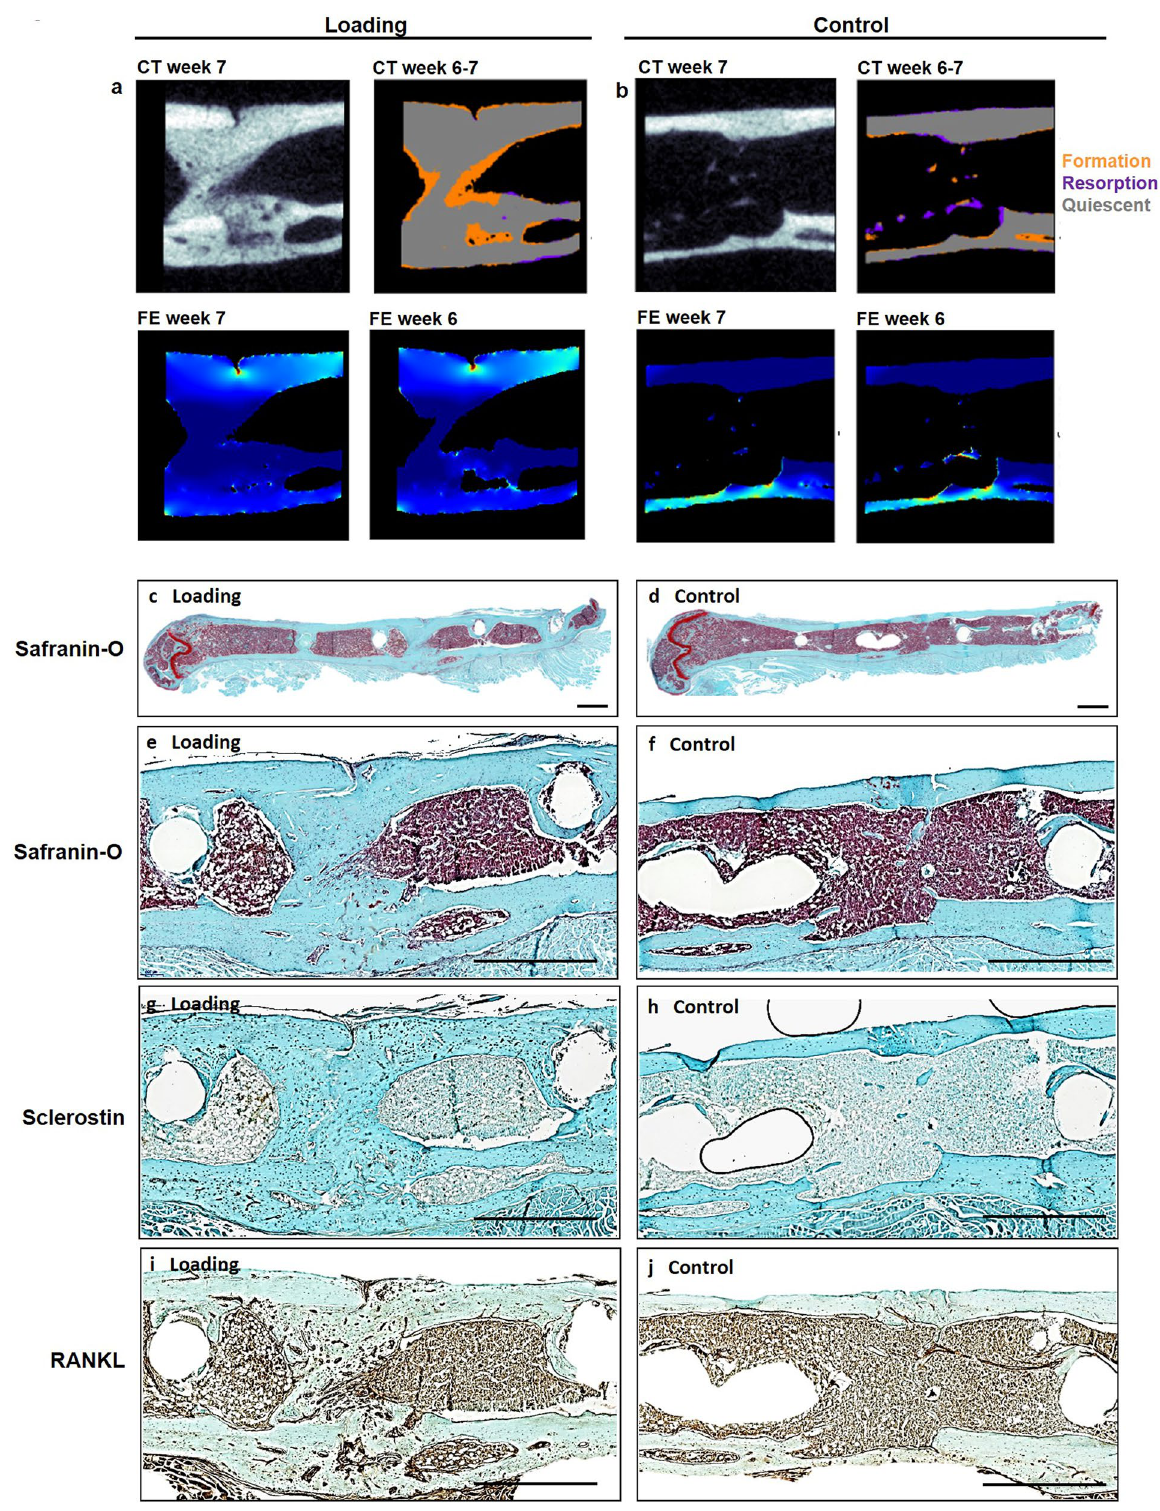
Figure 4. Micro-CT and histological analyses of consecutive callus sections. ( a , b ): Micro-CT images of fracture callus sections corresponding to sections stained with Safranin-O for one animal from the loading ( a ) and the control group ( b ): CT image (threshold: 395 mg HA/cm 3 ), visualization of regions of bone formation and resorption via registration of CT image from weeks 6 and 7, visualization of strains on CT section via micro-FE analysis for week 7 and week 6. ( c - j ). Consecutive longitudinal sections of fractured femora 7 weeks after defect surgery of one animal from the loading group and the control group stained for Safranin-O ( c - f ), Sclerostin ( g , h ), RANKL ( i , j ). Scale bar = 100 µm ( c , d ), scale bar = 500 µm ( e - j